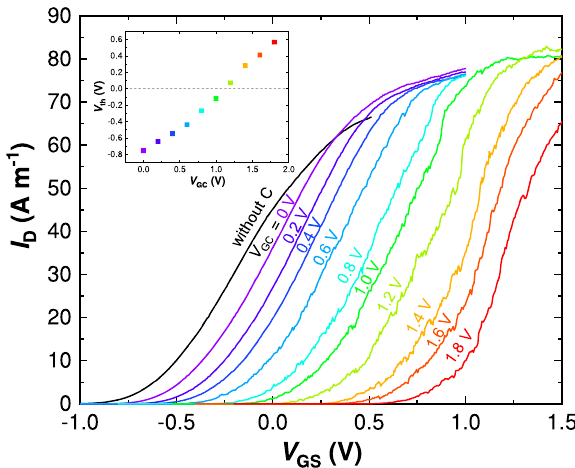
Fig. 4 The transfer curves of a dual-gate GESFET at different V GC and V DS = 1 V. The leftmost curve (black) corresponds to a GESFET in which the control gate is disconnected. Starting from the next curve (purple) and going to the right, V GC increases from 0 to 1.8 V in the steps of 0.2 V. The inset shows the threshold voltage V th of the GESFET (obtained from the transfer curves), which increases as V GC increases and becomes positive for V GC ≥ 1.2 V. Approximately, V th = 0.76 V GC − 0.83